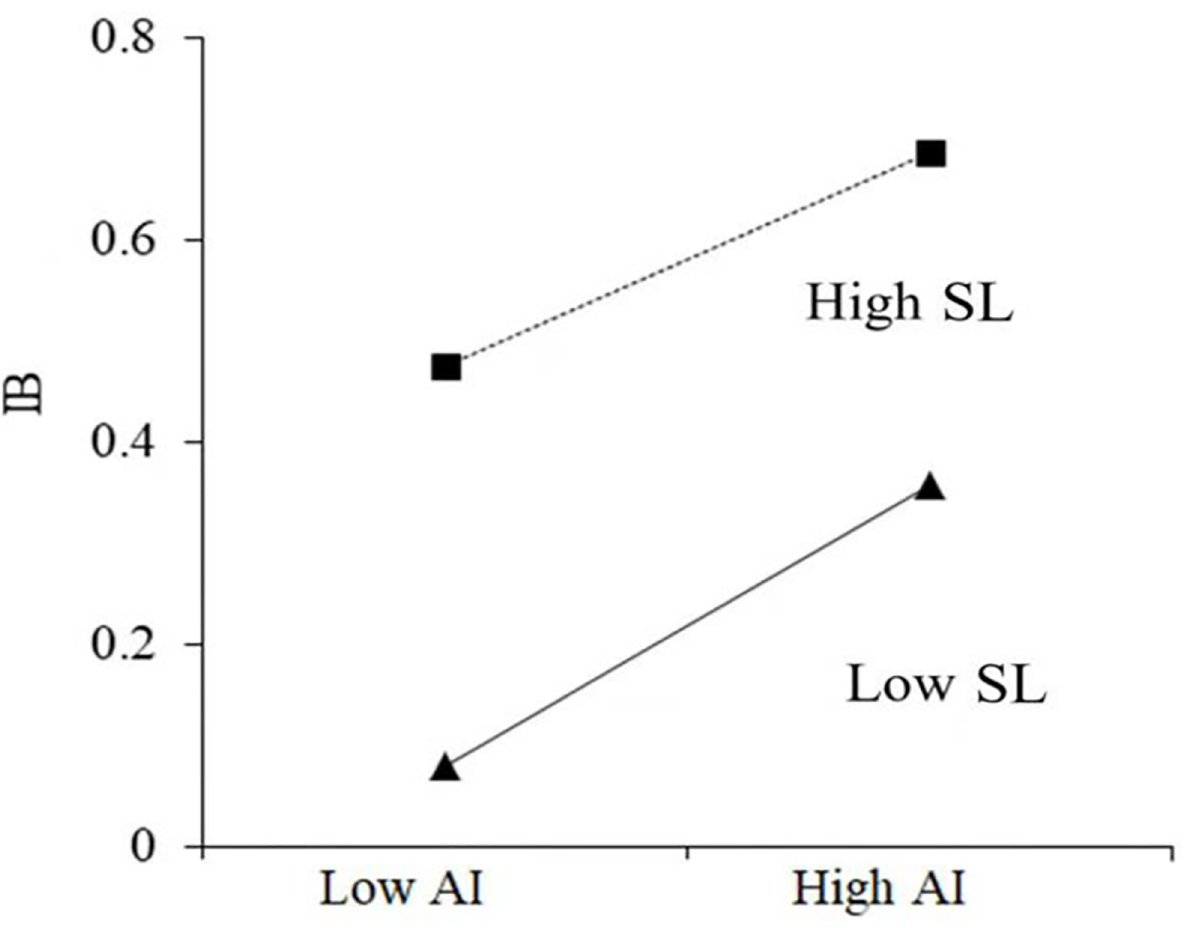
Fig 2. The moderating effect of SL on the relationship between AI and organization